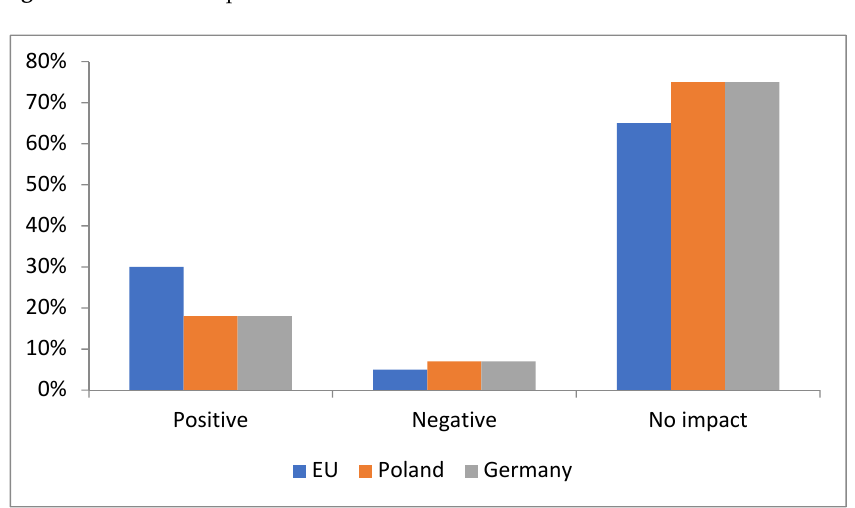
Figure 9. Opinion on demand.